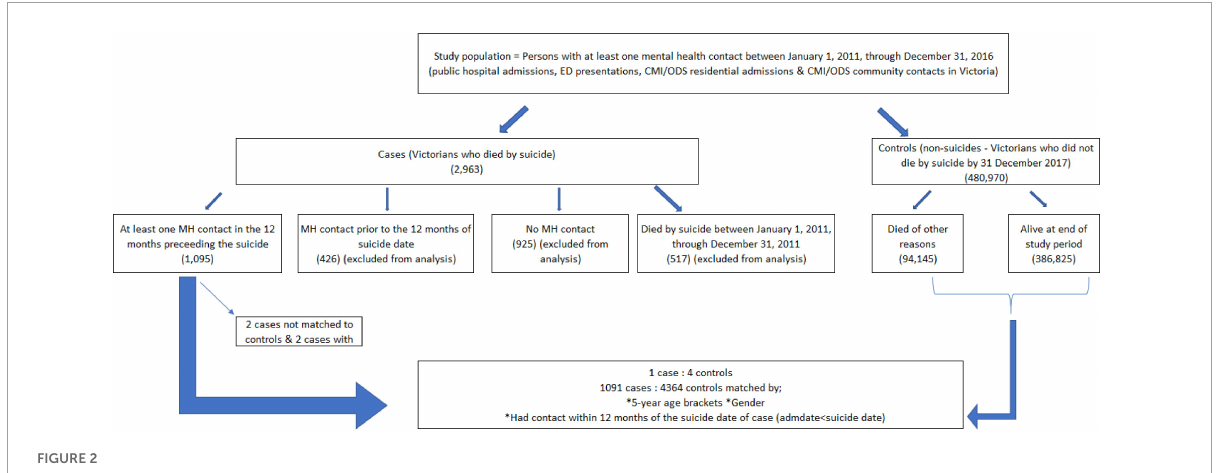
FIGURE2 Case and control selection process flow